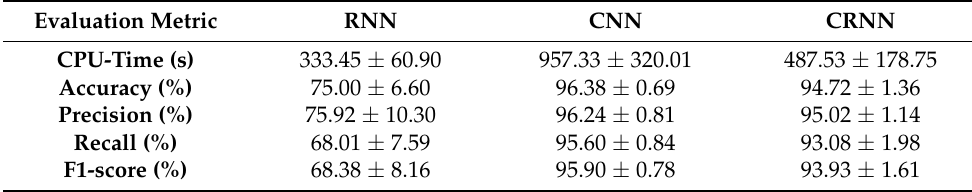
Table 12. Detection Results